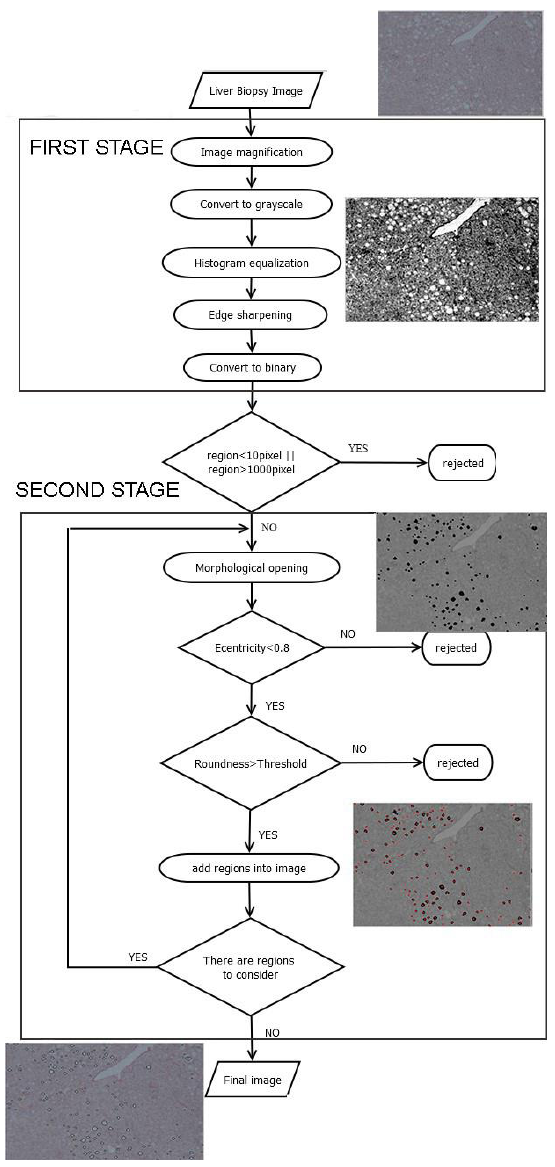
Figure 2 . Flowchart of the proposed methodology. Figure 2. Flowchart of the proposed